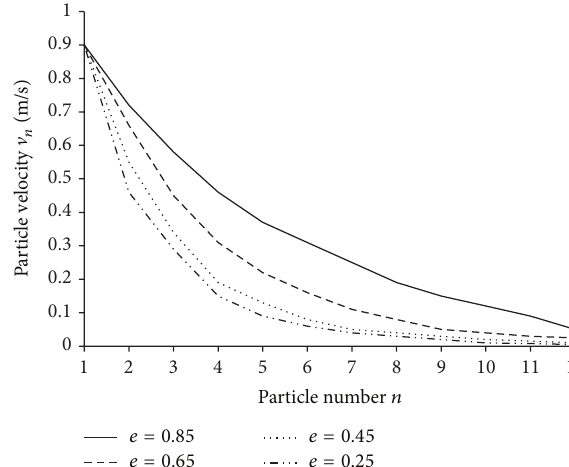
Figure 7: Effects of particle number 𝑛 and recovery coefficients 𝑒 on velocity V 𝑛 .